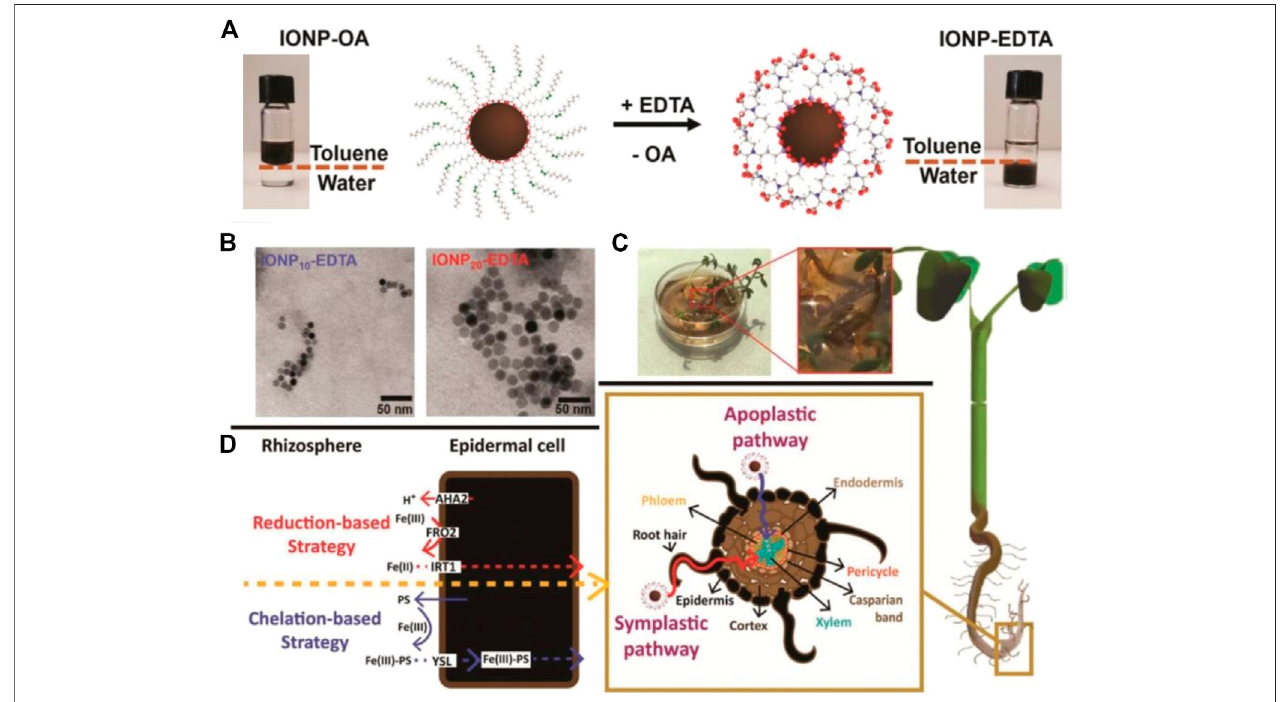
FIGURE 6 | (A) Schematic diagram of the ligand exchange process to generate water-soluble EDTA-capped iron oxide nanoparticles (IONP-EDTA) from as- synthesized oleic acid capped iron oxide nanoparticles (IONP-OA) (B) TEM images of IONP10-EDTA and IONP20-EDTA after plant incubation in hydroponic growth media (C) Representative photograph of IONP-EDTA samples concentrating around the root hairs of garden cress after 30 min of incubation (D) Schematic representation of the pathways for the uptake of Fe through the plant roots. Copyright 2019, Royal Society of Chemistry (Ju et al., 2019).